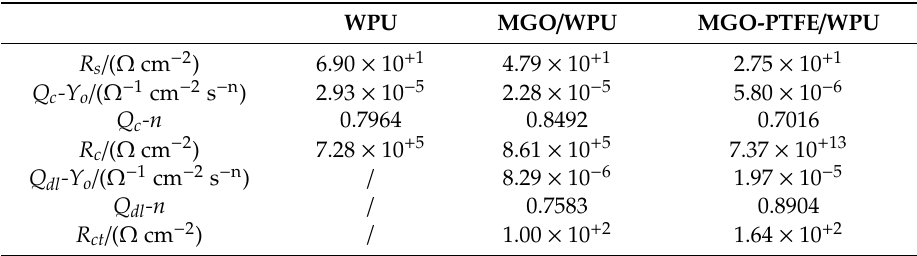
Table 3. Fitting data of pure WPU coating, 1.0 wt.% MGO/WPU composite coating and 1.0 wt.% MGO-PTFE/WPU composite coating.